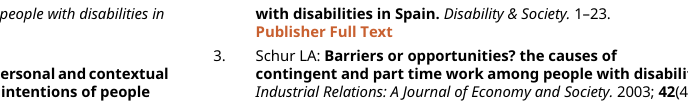
Data are available under the terms of the Creative Commons Attribution 4.0 International license (CC-BY